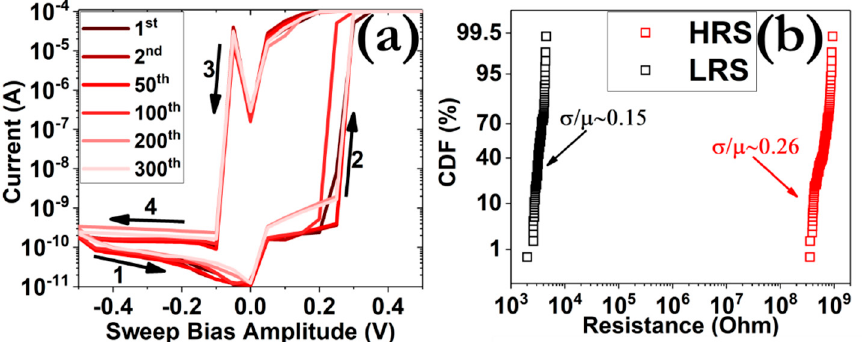
Figure 2. ( a ) I–V cycling behavior during the application 300 consecutive hysteresis loops and ( b ) cumulative distribution functions (CDF) of both low-resistance state (LRS) and high-resistance state (HRS) responses during DC consecutive operation from 100 different memory cells on the same sample. The resistance values were extracted at a read out voltage of 100 mV.